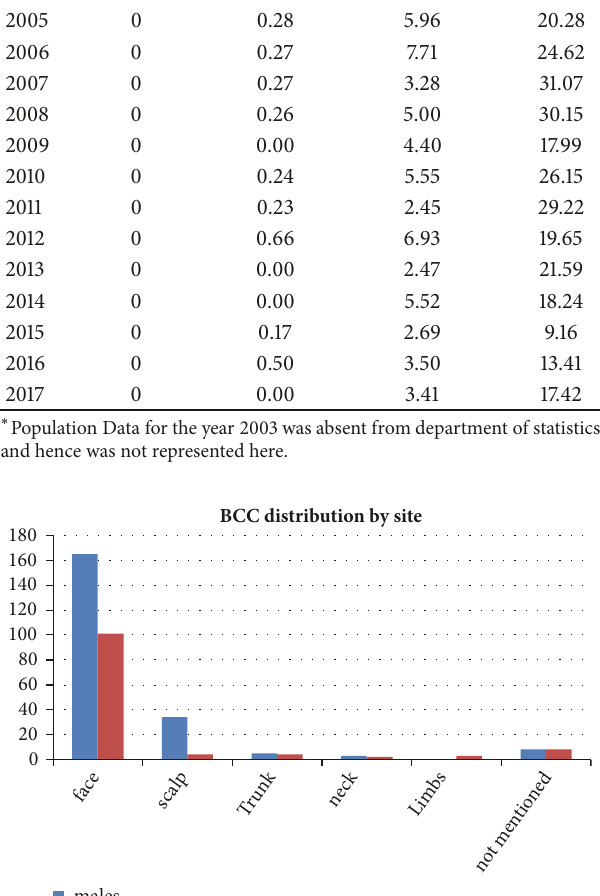
Figure 3: BCC distribution according to